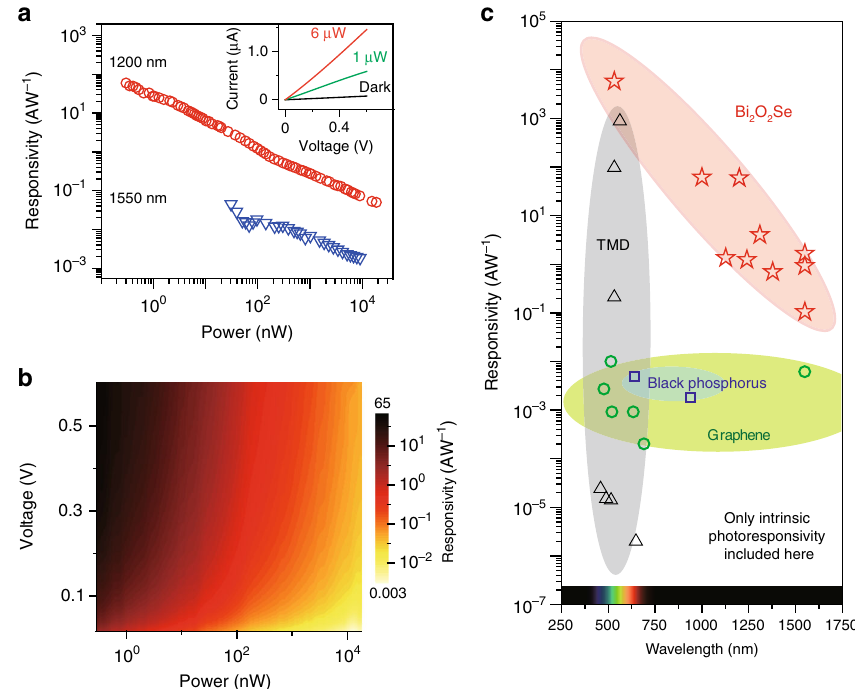
Fig. 2 High photoresponsivity of 2D Bi 2 O 2 Se photodetector. a Photoresponsivity under 0.6 V bias at wavelengths of 1200 nm and 1500 nm. b Dependence of photoresponsivity with incident power and voltage bias at 1200 nm wavelength. c Comparison of photodetectors based on Bi 2 O 2 Se, graphene, black phosphorus, and transition metal dichalcogenides (TMDs) 8,9,21,24 – 29,36 . Note that the data only includes the photocurrent generation through excitation of interband transitions without further treatment such as adding waveguide structure or plasmonic